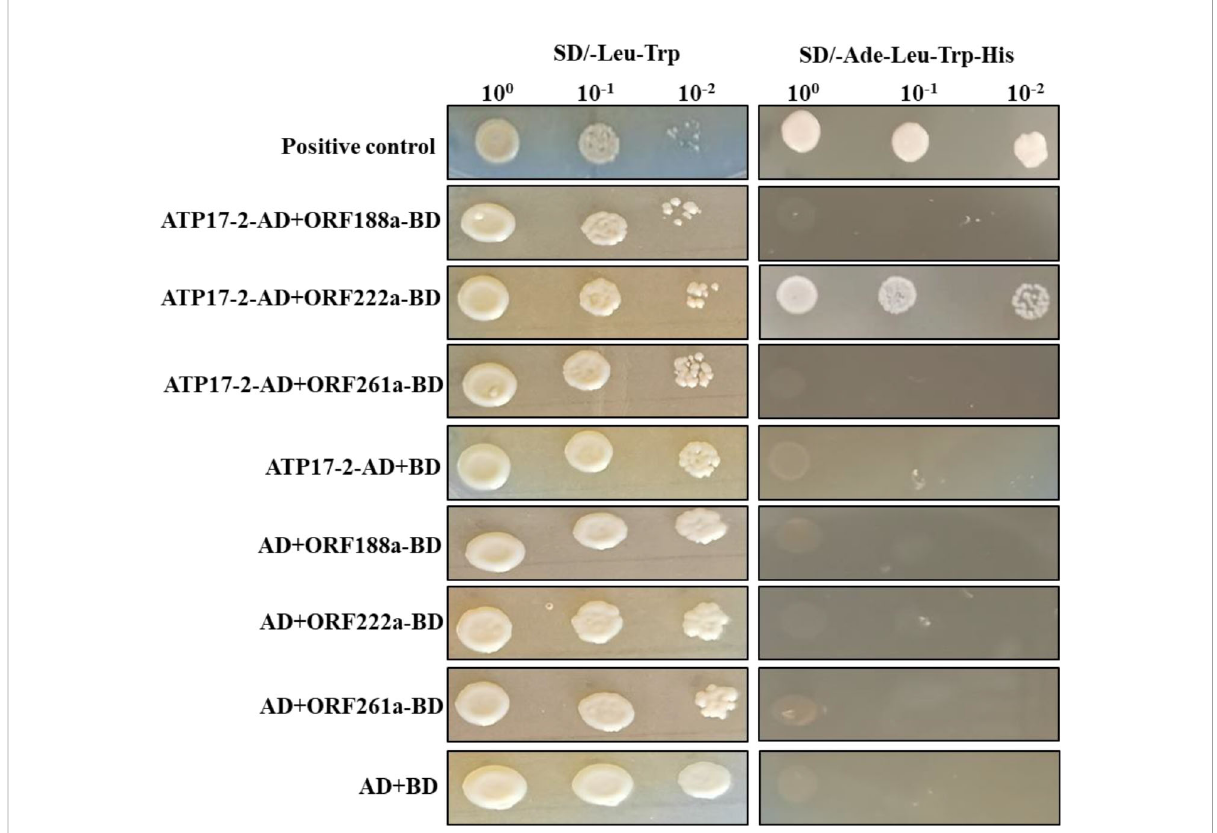
FIGURE 8 Y2H assay of the interaction of ORF222a with ATP17-2. Serial dilutions of cotransformed yeast were spotted on synthetic dropout SD/-Trp-Leu medium to select for cotransformants and SD/-Trp-Leu-His-Ade medium to select for positive interactions. p53 was used as a positive